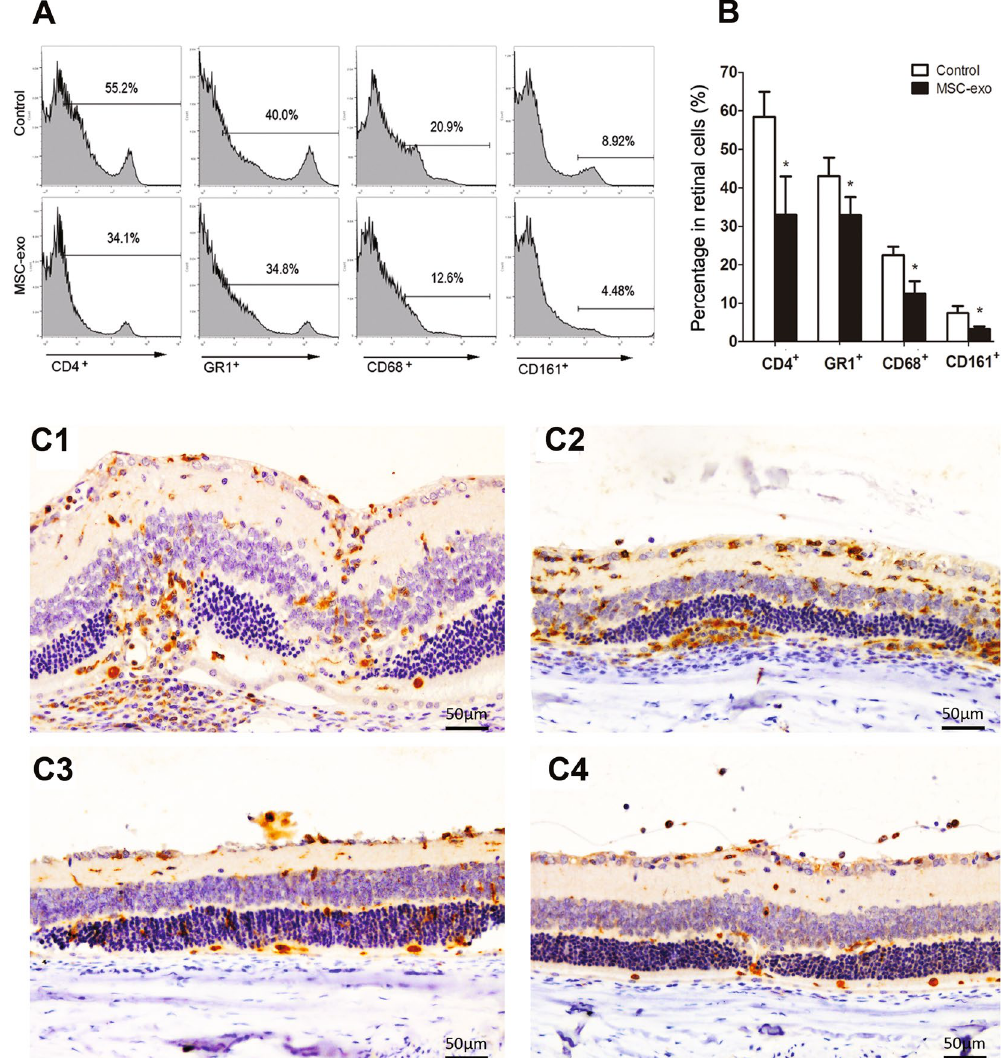
Figure 5. Analysis of the leukocytes infiltration in eyes. ( A and B ) On day 15 after immunization, representive figures of FACS analysis of CD4 + , Gr-1 + , CD161 + and CD68 + cells in eyes; C: CD68 immunostaining was used to observe macrophage infiltration in the eyes on day 15 and 20 after immunization (C1: control goup, day 15; C2: control group, day 20; C3: MSC-exo treated group, day 15; C4: MSC-exo treated group, day 20). Values are expressed as the mean ± SD of six rats (12 eyes) per group. * P <